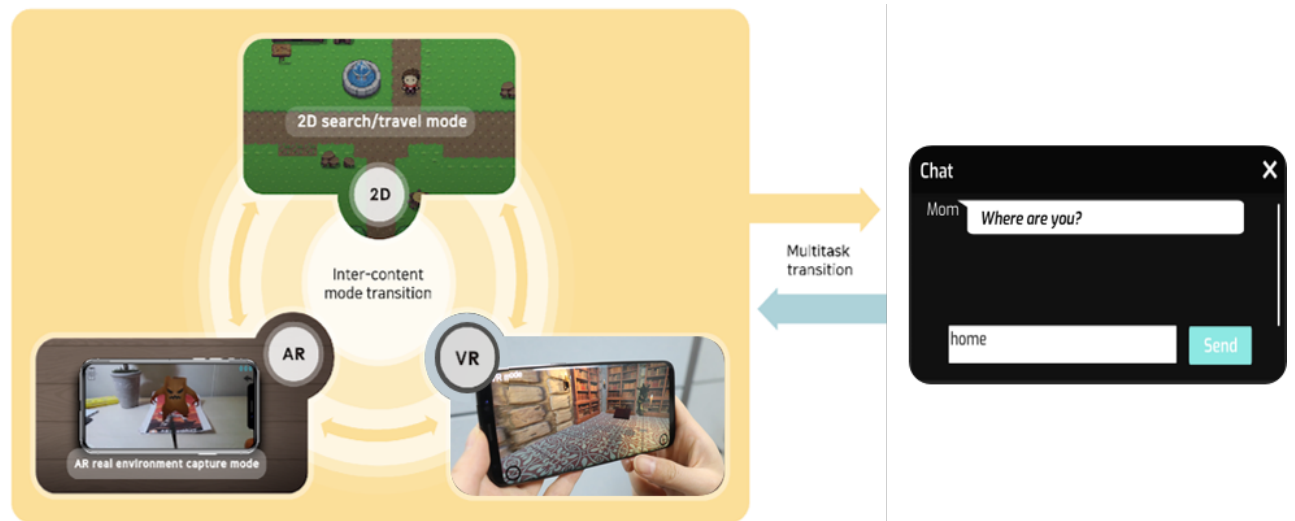
Figure 3. Multi-mode XR application called MonsterGo, that is multi-taskable with the regular apps (like texting and making phone calls). It has three different modes—2D for map-based exploration and search, 3D VR for first-person battles, and AR for interaction in the real